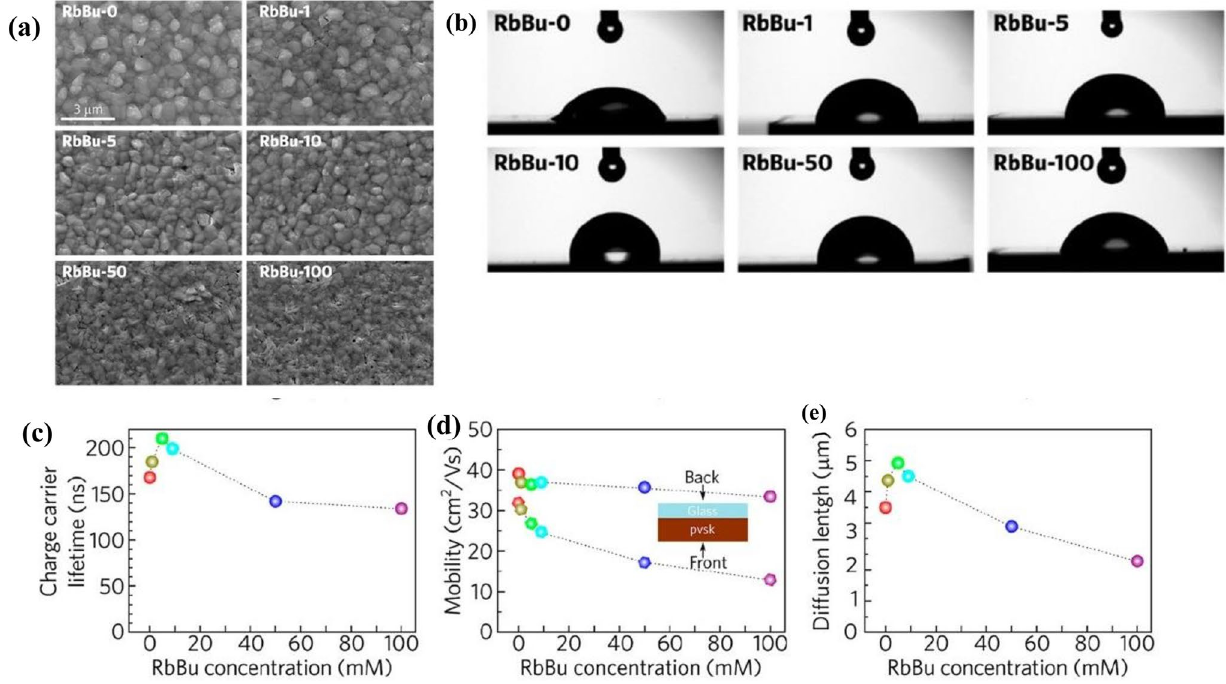
lengths considering front face excitation as a function of the RbBu concentration. Adapted with permission from ref. [92],